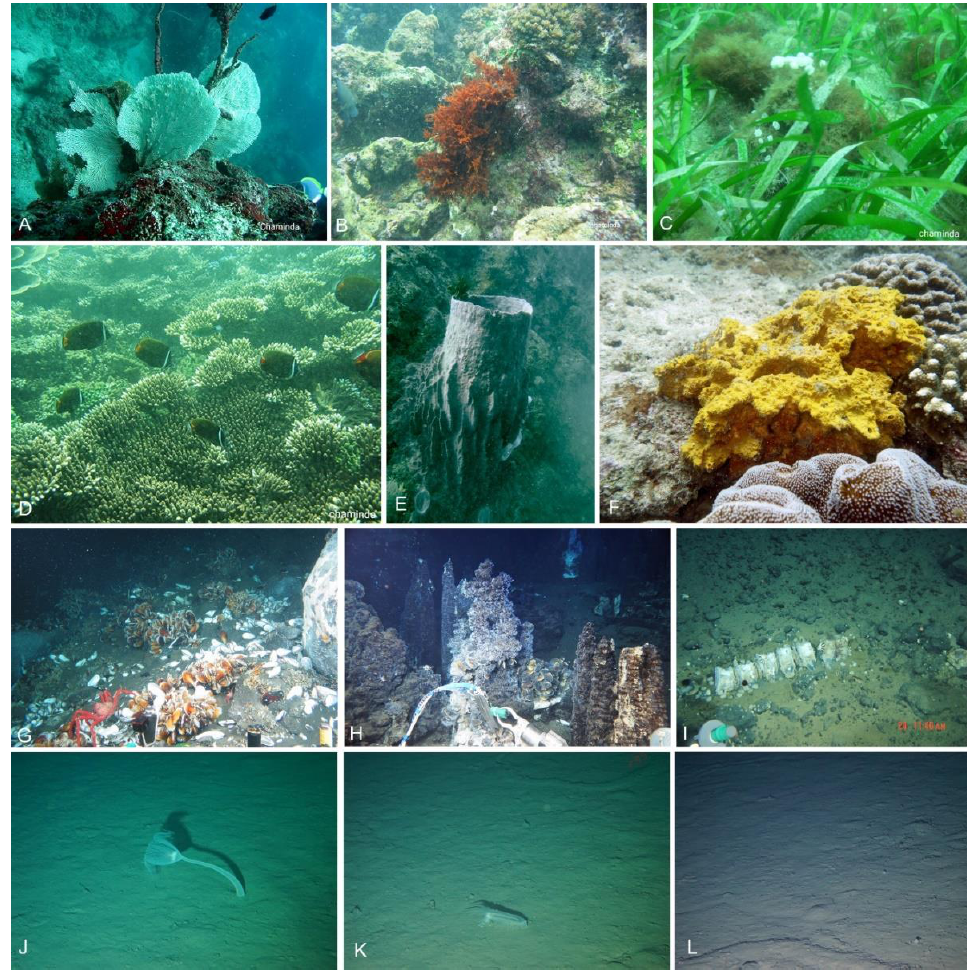
Figure 5. Coastal marine and deep marine habitats. ( A – F ), coastal marine ecosystems. ( G – L ), deep marine ecosystems. Credit: pictures ( A – D ), M.M.C. Karunarathne; pictures ( E , F ), P. Cárdenas.